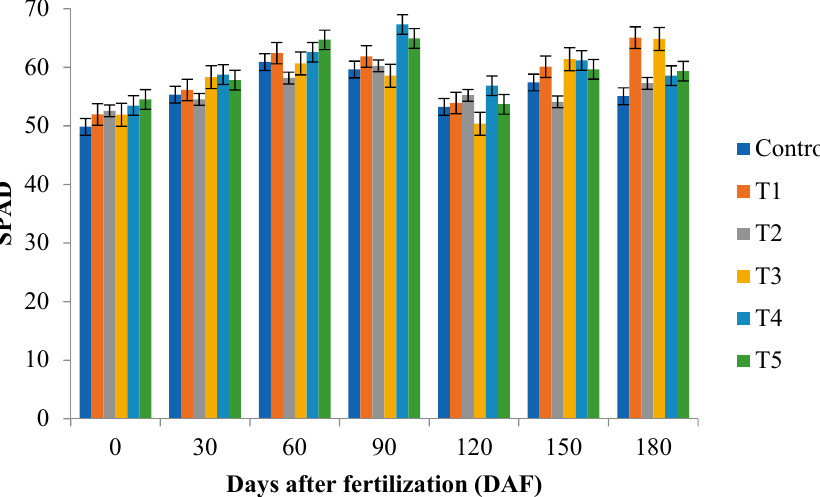
Figure 1. Relative chlorophyll content (SPAD) of cocoplum plants grown in different fertilization